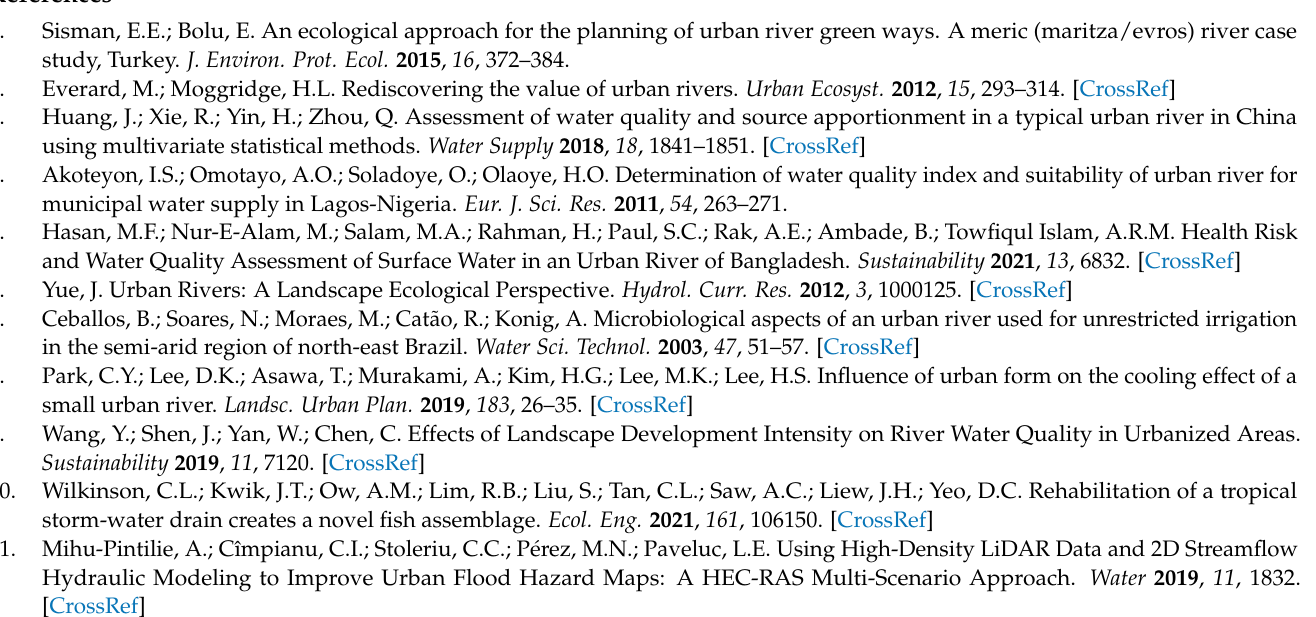
Table S2. The R-square and core consistency of PARAFAC model in different components; Table S3. Loadings of different fluorescence components for principal coordinates analysis; Figure S1. Split- half analysis of optimal four-component PARAFAC model; Figure S2. Correlations of different fluorescent